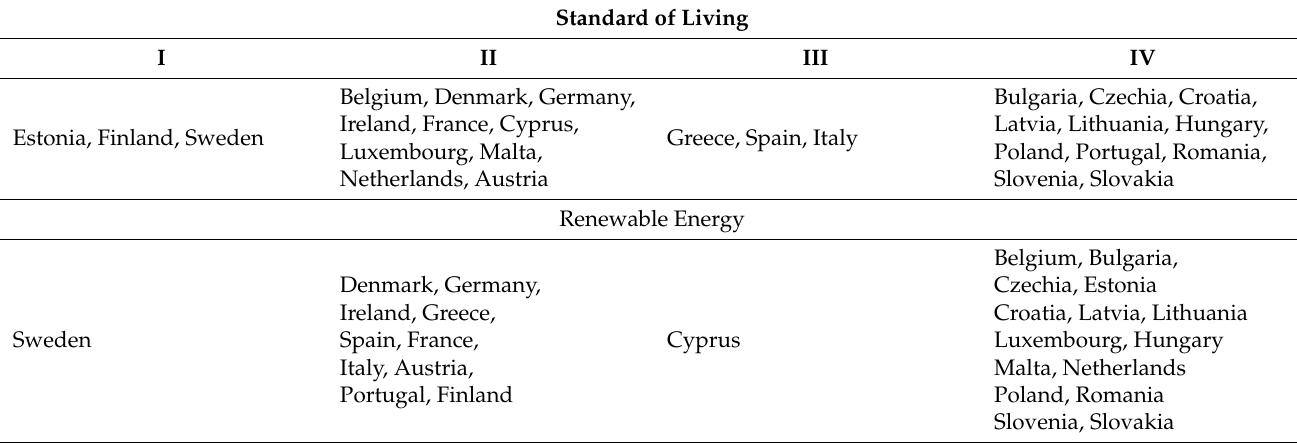
Table 4. Results of grouping the EU countries according to the standard of living and the level of renewable energy development.